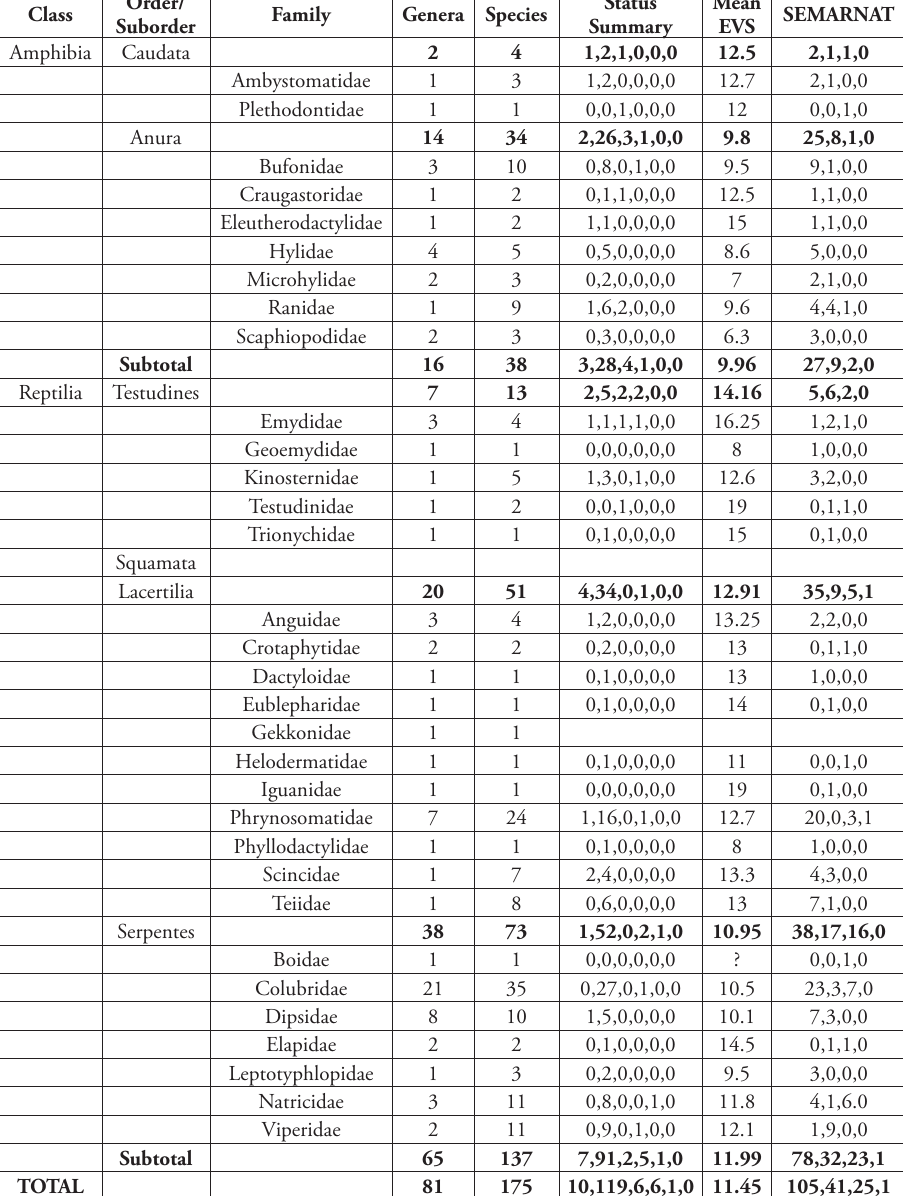
Table 2. Summary of species present in Chihuahua by family, order or suborder, and class. Status sum mary indicates the number of species found in each IUCN conservation status in the Order DD, LC, V, NT, E, CE (see Table 1 for abbreviations; in some cases species have not been assigned a status by the IUCN and there- fore these may not add up to the total number of species in a taxon). Mean EVS is the mean Environmental Vulnerability Score, scores ≥ 14 are considered high vulnerability (Wilson et al. 2013a,b) and conservation status in Mexico according to SEMARNAT (2010) in the Order NL, Pr, A, P (see Table 1 for